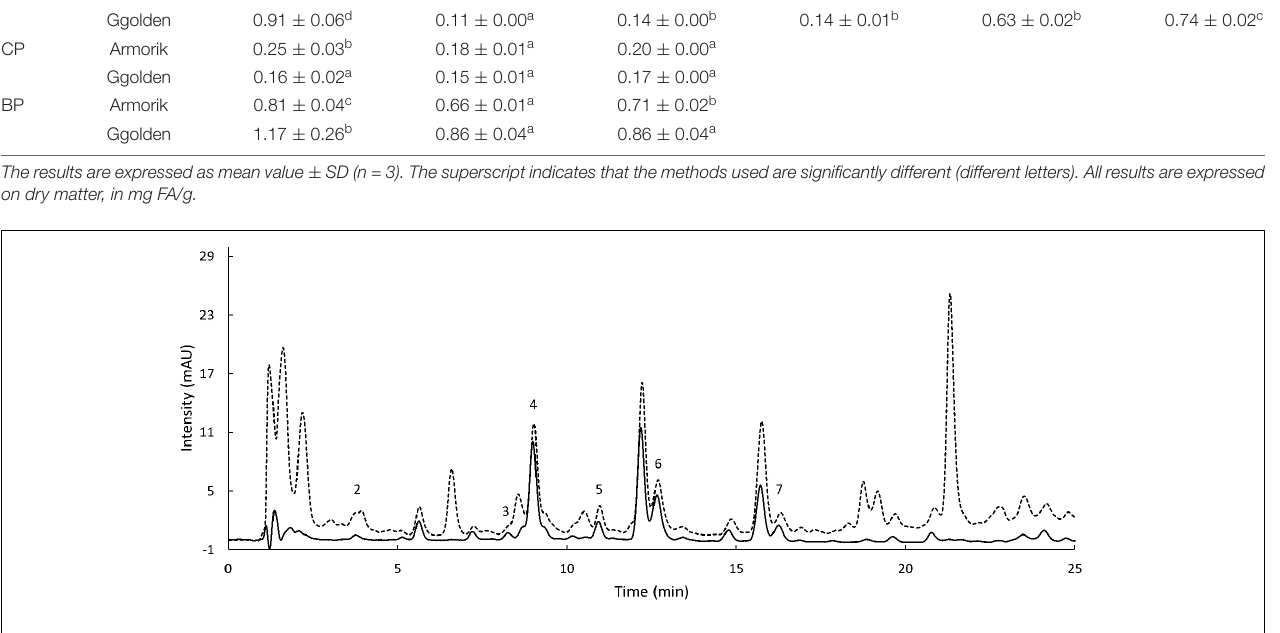
FIGURE 3 | Chromatogram of the free phenolic fraction of Armorik variety, extracted with ethanol 80%, before ethyl acetate extraction (Method 5, dash line) and after (Method 3, solid line), recorded at 268 nm. 2: protocatechuic acid, 3: vanillic acid, 4: caffeic acid, 5: syringic acid, 6: P -coumaric acid, and 7: ferulic acid. The injection volume was 10 µ l. TABLE 3 | Summary of extraction trials for flavonoids performed on Armorik and Ggolden varieties. Method A (Dykes et al., 2011) with a second 10-min extraction (1 g of the sample in 10 ml)